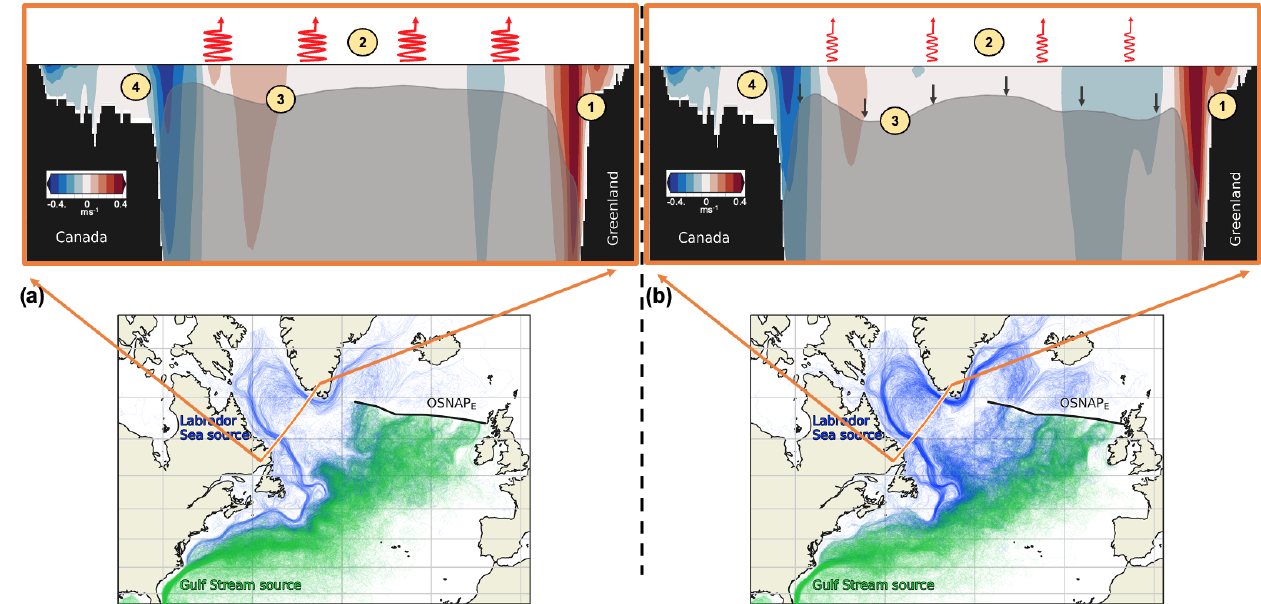
Figure 15. Diagram illustrating the mechanism for reduced surface heat loss leading to increased outflow from the Labrador Sea: (a) late 1990s/early 2000s for a period of higher heat loss (zig-zag red lines); (b) early 2010s for the period of reduced heat loss (small zig-zag red lines). The upper panels show water mass densities (the less-dense upper layer is shown as clear and denser intermediate and deep waters are dark grey) and mean velocities across OSNAP W (red is northward and blue is southward). The lower panels present the number of backward tracks crossing OSNAP W and show the contrasting transport pathways to OSNAP E . During the two periods, the inflow of light waters along West Greenland (1) remains similar in thickness and velocity structure. Reduced surface heat loss (2) in the freshening period (b) leads to less transformation from light to deep water, deepening the less dense layer (3) and so increasing the outflow of the light waters on the Labrador Shelf (4). The lower panel shows how the proportion of water from the Labrador Sea (blue) increases and pushes eastward at OSNAP E during the freshening event (b) . The Gulf Stream origin water decreases in volume and is confined more to the eastern end of the OSNAP section. While total transport from the Labrador Sea is higher in (b) than (a) , transport via the loop path southward along the eastern US has decreased in (b) . Most of the increased flow from the Labrador Sea is water circulating in the